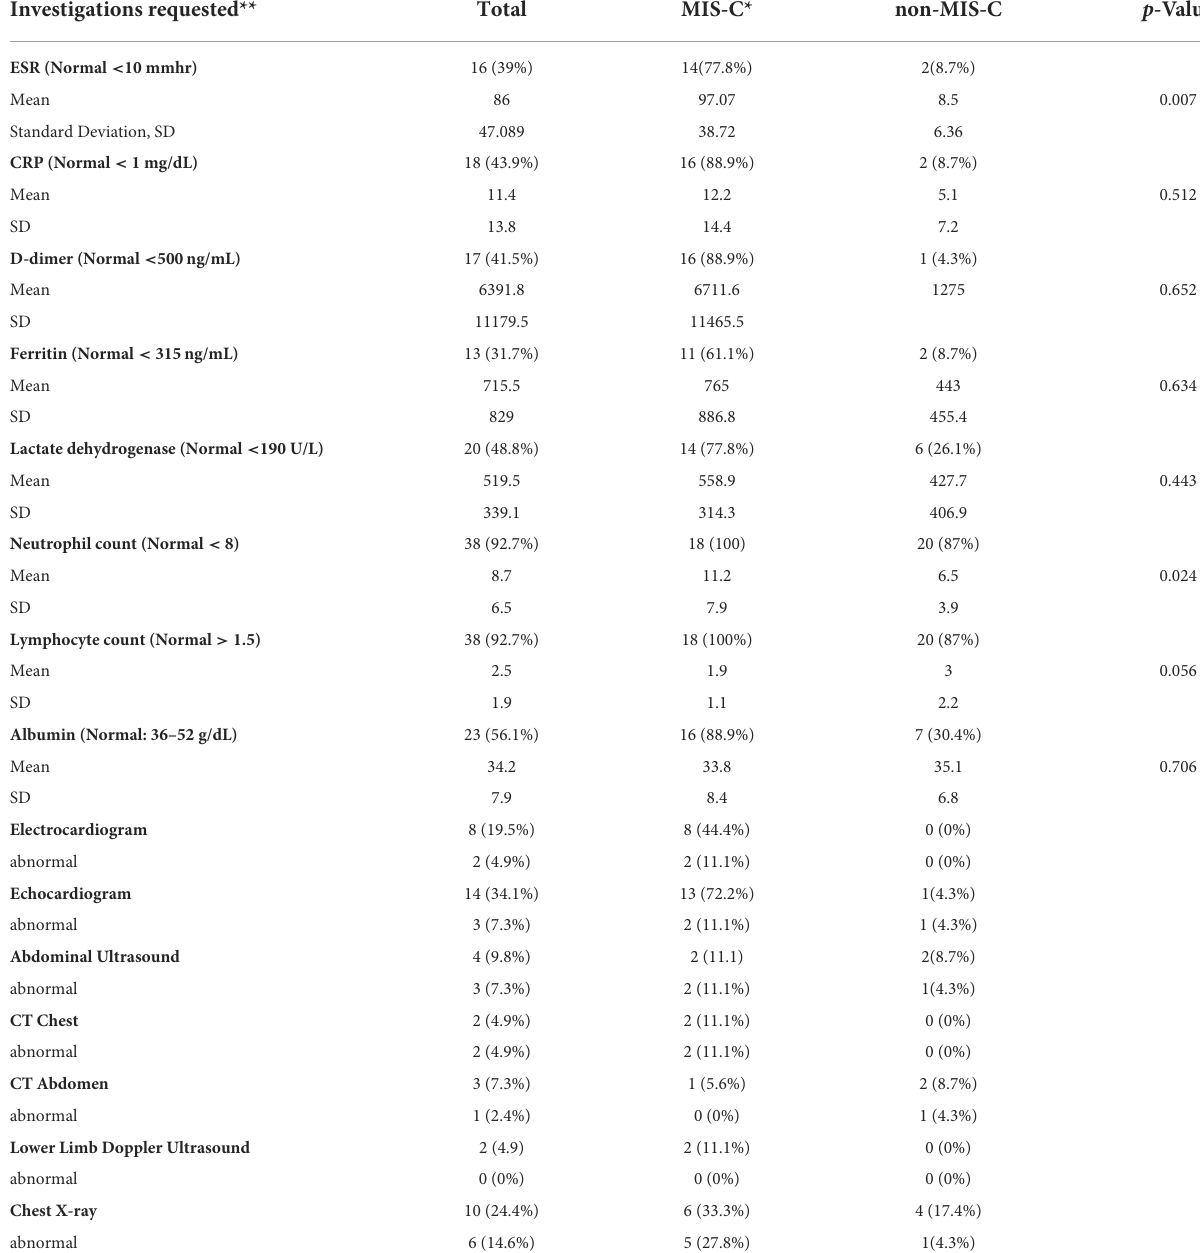
TABLE 4 Investigations of children hospitalized with COVID-19, MIS-C * vs.